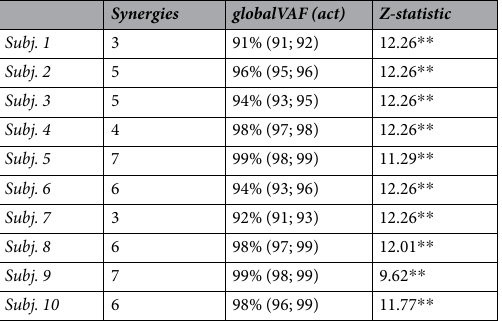
Table 1. Synergy extraction parameters. Minimum number of muscle synergies able to satisfy both local (VAF > 75%) and global reconstruction criteria (VAF > 90%). VAF values are reported as median and confidence intervals of variance accounted for. Z-statistics (right-sided Wilcoxon signed rank test) tested whether global VAF extracted from actual data was higher than VAF obtained from random data. ** for p - values <